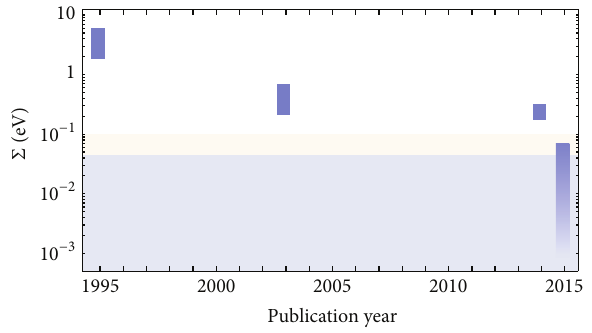
Figure 8: Evolution of some significant values for Σ as indicated by cosmology, based on well-known works [133–136]. Since the error for the first value is not reported in the reference, we assumed an error of 50% for the purpose of illustration. The yellow region includesvaluesof Σ compatiblewiththe NH spectrum,butnotwith the IH one. The gray band includes values of Σ incompatible with the standard cosmology and with oscillation experiments.